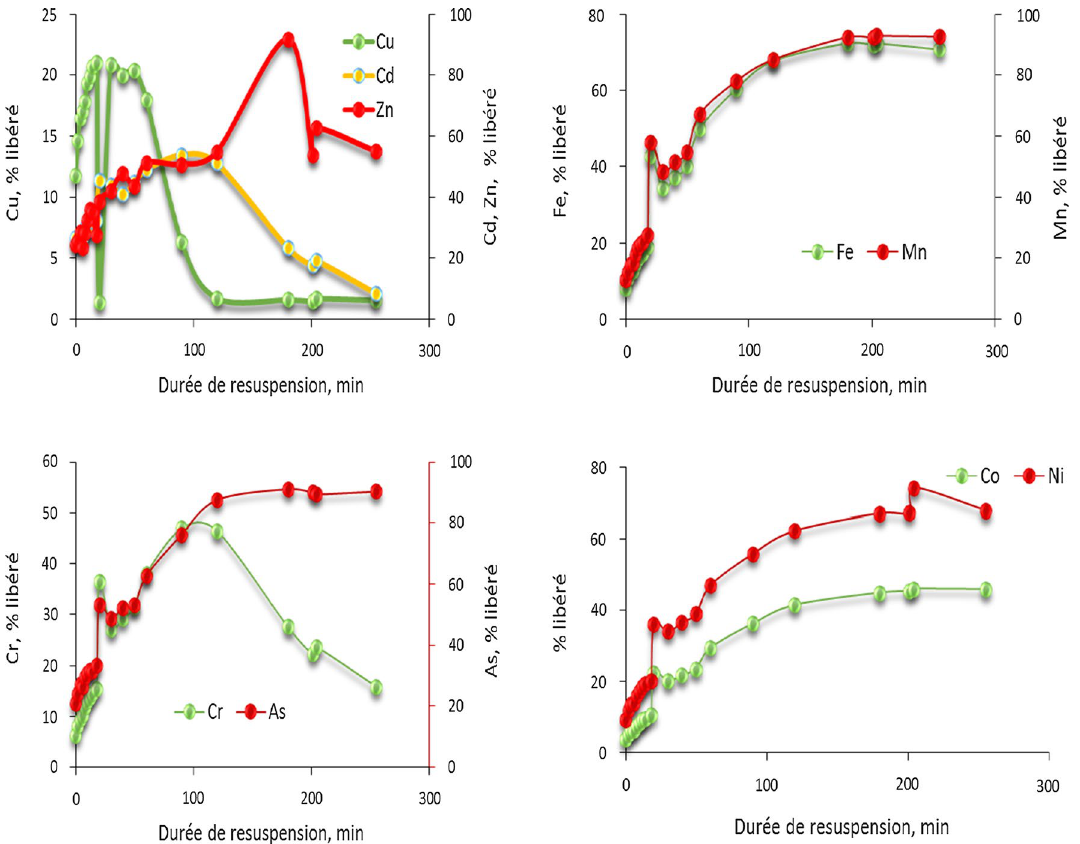
Fig. 5 Mobilization percentage (%) EMT during the kinetics of mobilization of the sediment under reductive conditions in nitrogen atmosphere and pH